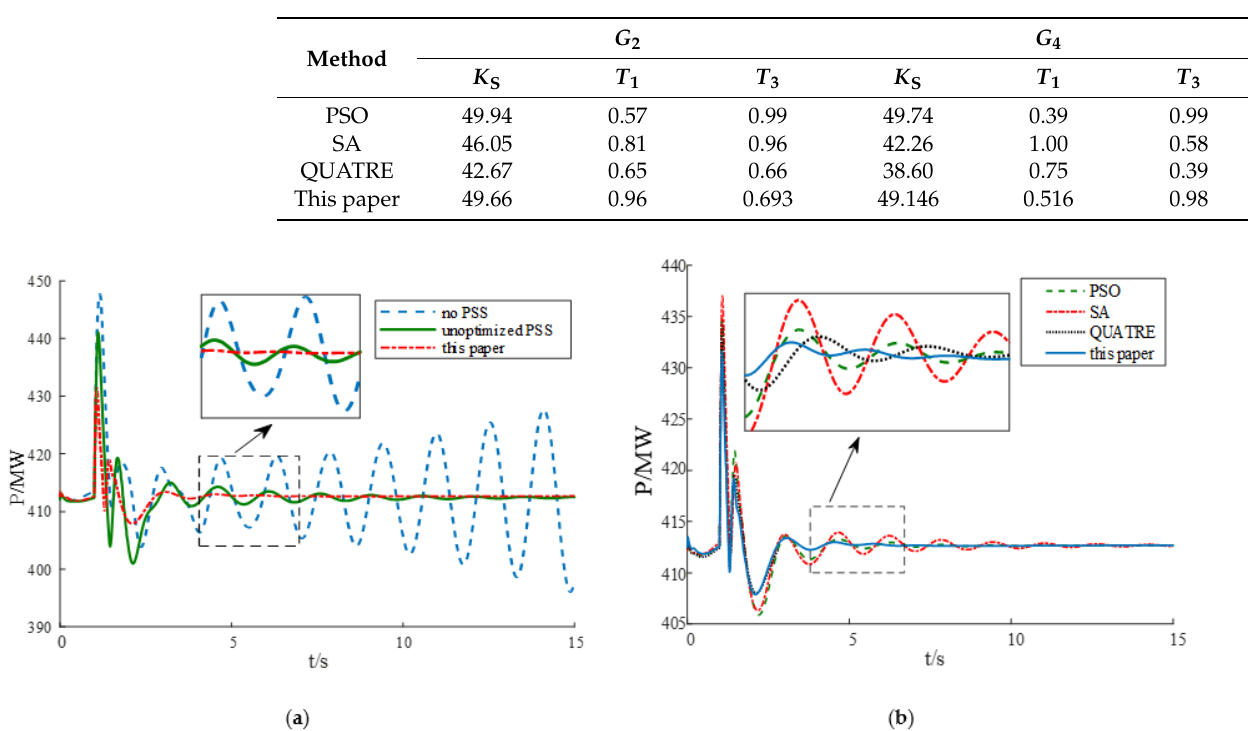
Table 4. Electromechanical modes without PSS.